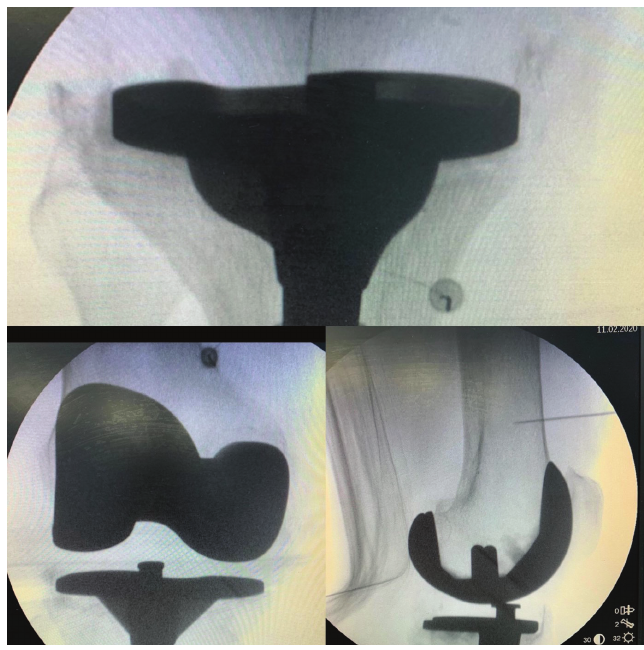
Figure 1 - Flouroscopic view of radiofrequency